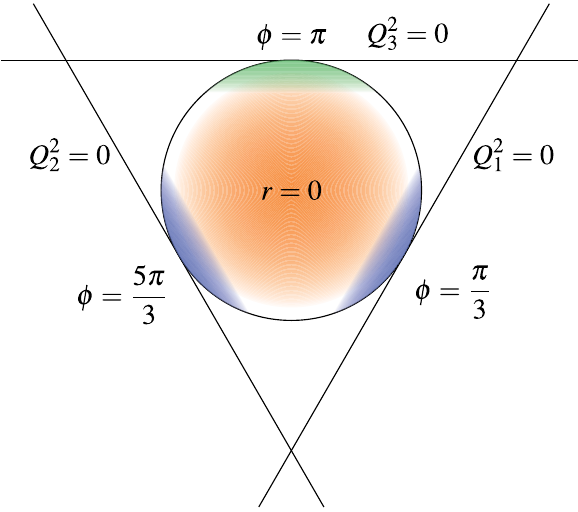
Fig. 1 The circle represents the boundary of the g − 2 integration domain for a fixed value of Σ . The angles φ = π/ 3, φ = π and φ = = Q 2 = Q 2 = Q 2 5 π/ 3 correspond to Q 2 , Q 2 and Q 2 , respectively. 2 3 1 2 1 3 The colored regions denote where SDCs on ¯ Π 1 hold at large Σ . The blue domains yield contributions to ¯ Π 1 from the OPE expansion of the VVA correlator that are sub-leading compared to the green one, while the orange region corresponds to the pQCD